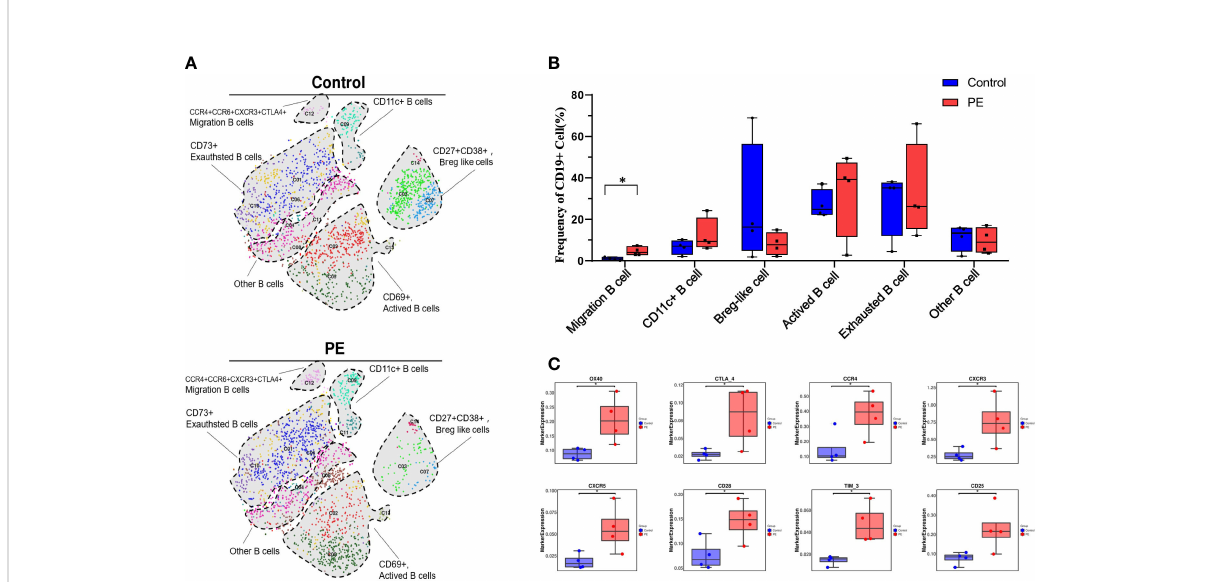
FIGURE 2 Total B cells decreased while the migration of B cells increased signi fi cantly in PE patients compared with healthy controls. (A) t-SNE plot of 14 clusters of B cells annotated by CD45+CD19+CD66b-CD3- from the PE and control groups and merged into six subsets, namely,